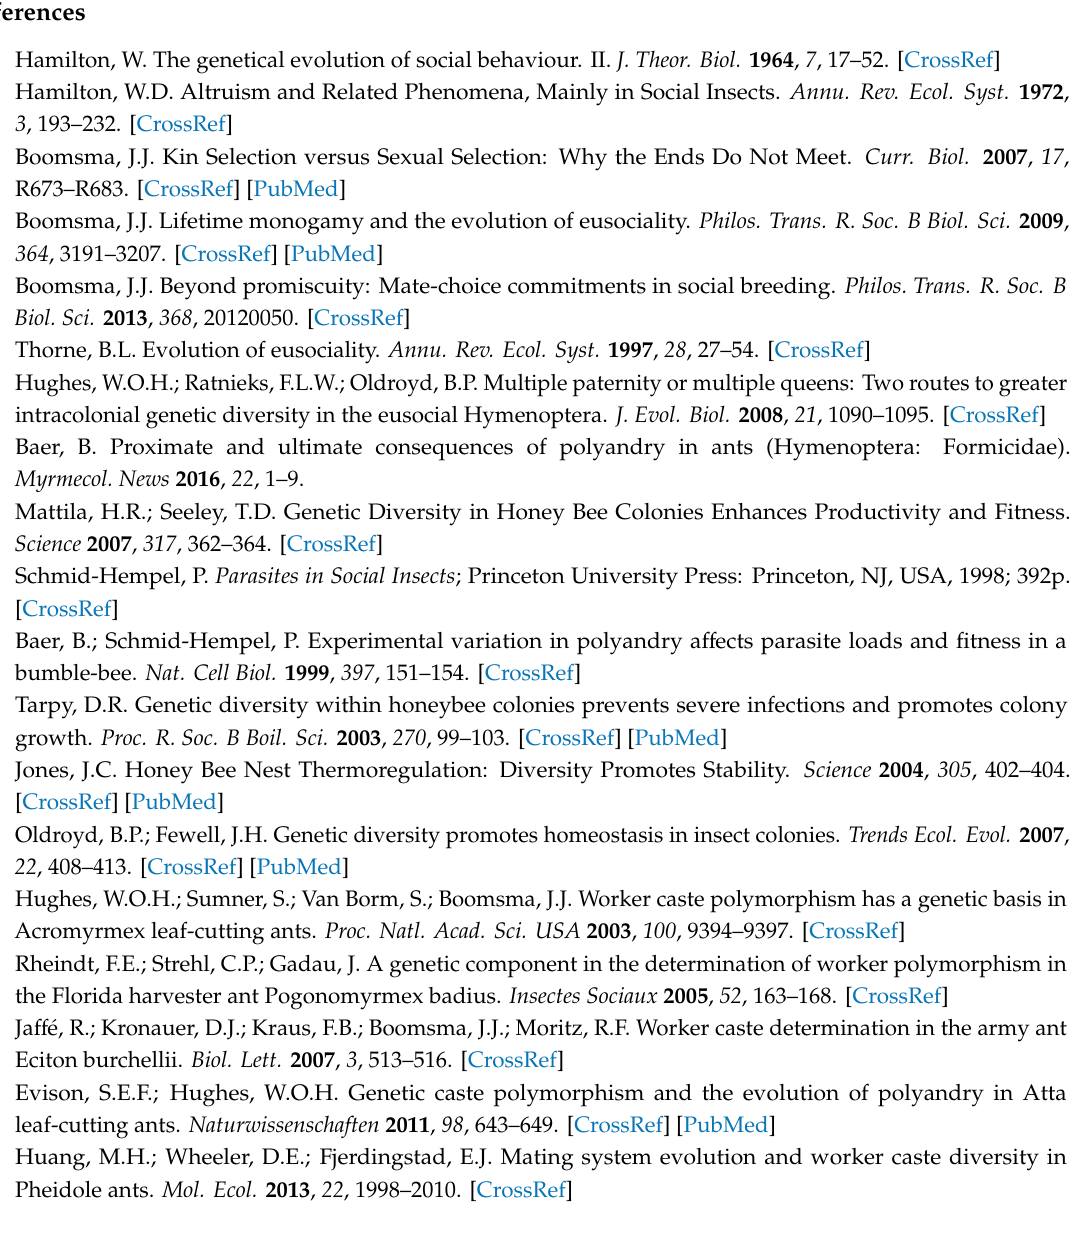
Table S1: Sampling coordinates of the 13 study colonies of M. bagoti , Table S2: Microsatellite markers used in the genetic analyses of M. bagoti , Table S3: Microsatellite genotypes in genepop